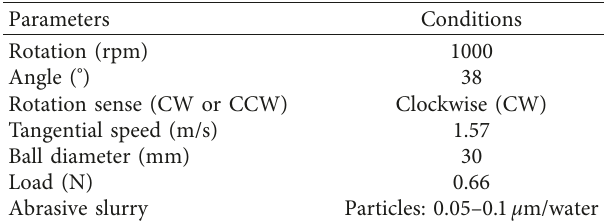
Table 1: Parameters used in the ball-cratering